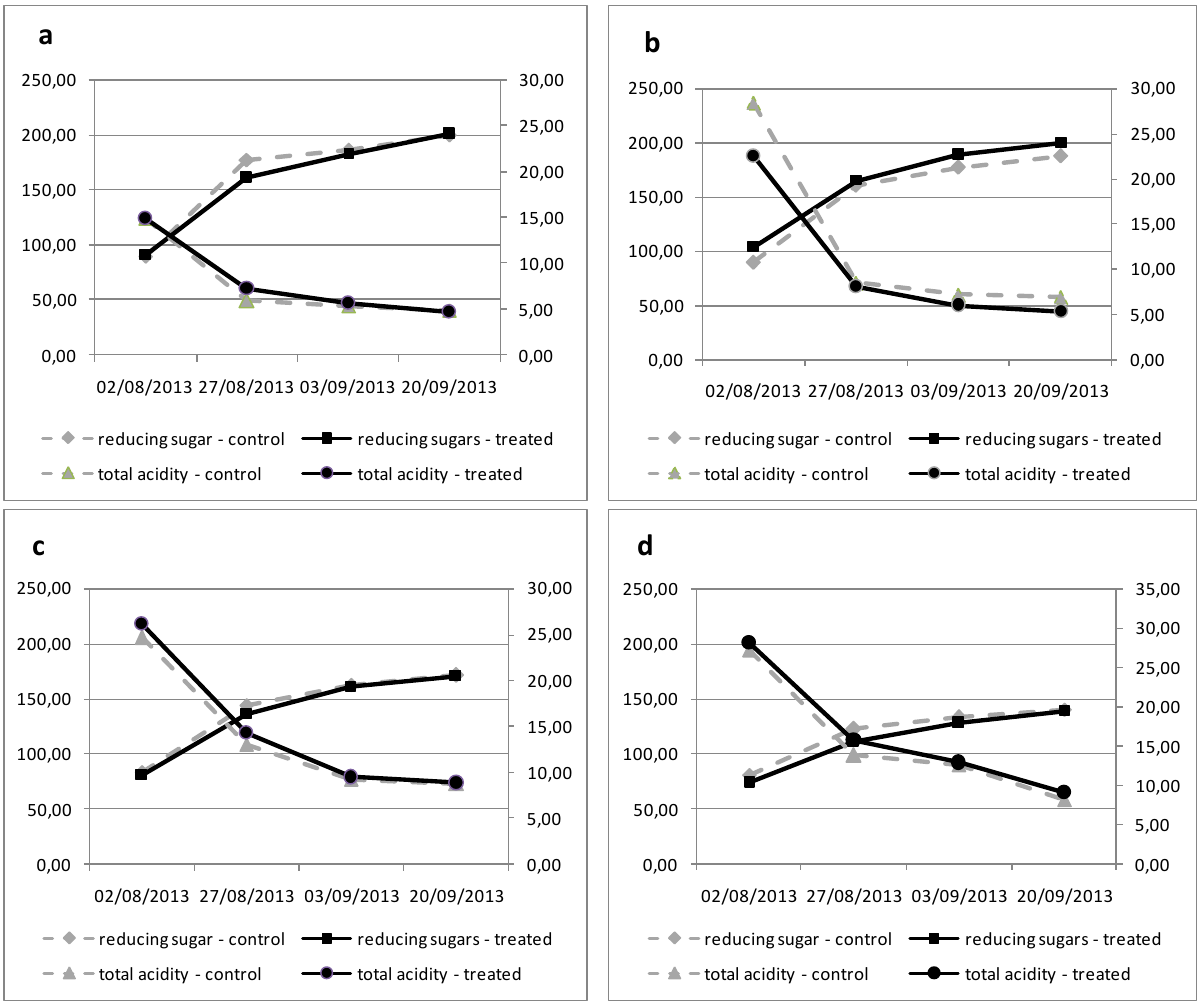
Figure 4. Maturation curves of the yield of healthy (a), asymptomatic (b) and symptomatic [asymptomatic (c) and symptomatic (d) shoots] vines affected by GLSD in the Controguerra vineyard in 2013. The figure show total sugars and total acidity contents of treated and untreated vines of each status of vines at each of the four growth stages: 'Beginning of ripening: berries start to develop variety-specific color' (81); 'Berries developing color' (83); 'Softening of berries' (85); and 'Berries ripe for harvest' (89).